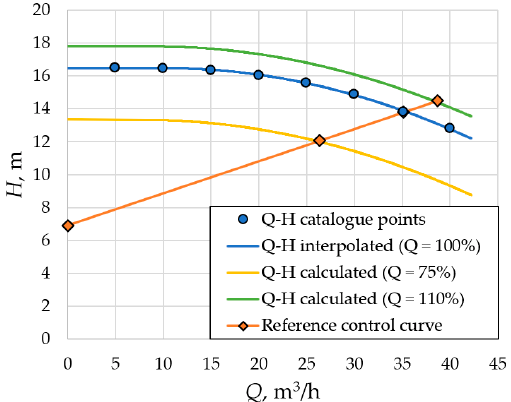
Figure 4. Calculated head-flow curves of the pump at 75, 100, and 110% flow and initial points of the 2.2 kW pump, and reference control curve. Table 4. Performances of the pumps of different power ratings during the operating cycle.